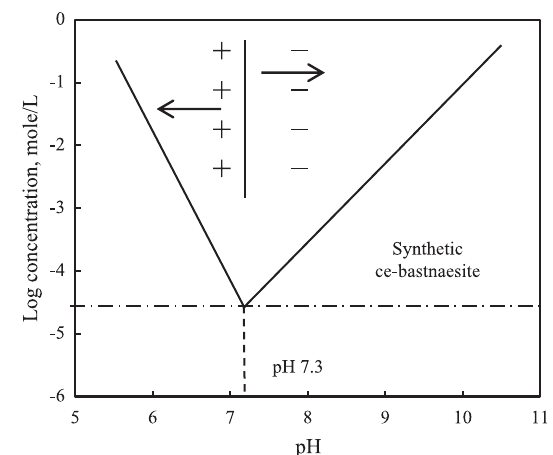
Fig. 3 Electrophoretic mobility of synthetic cerium bastn- aesite as a function of pH in the presence and absence of sodium carbonate (1 minute conditioning).